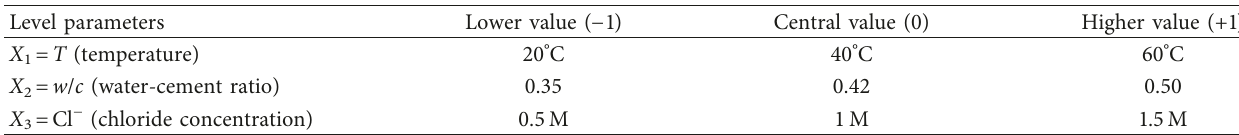
Table 1: Variable